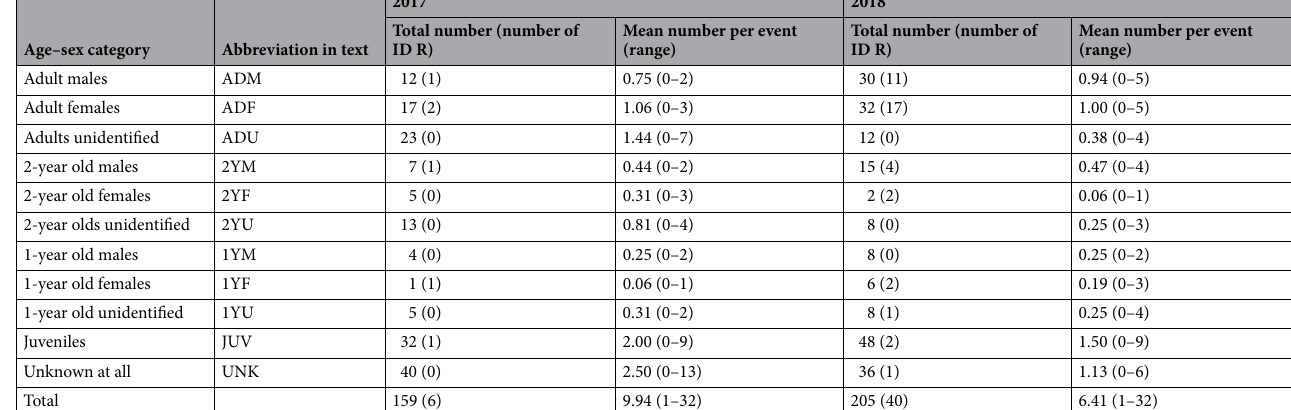
Table 2. Composition of the Western Derby eland herds recorded in the Niokolo Koba National Park, according to the defined age and sex categories, in both 2017 and 2018. The total numbers represent the total number of animals recorded, and therefore the absolute numbers are not directly comparable between years. ‘ID R’ refers to the individually recognized (identified)